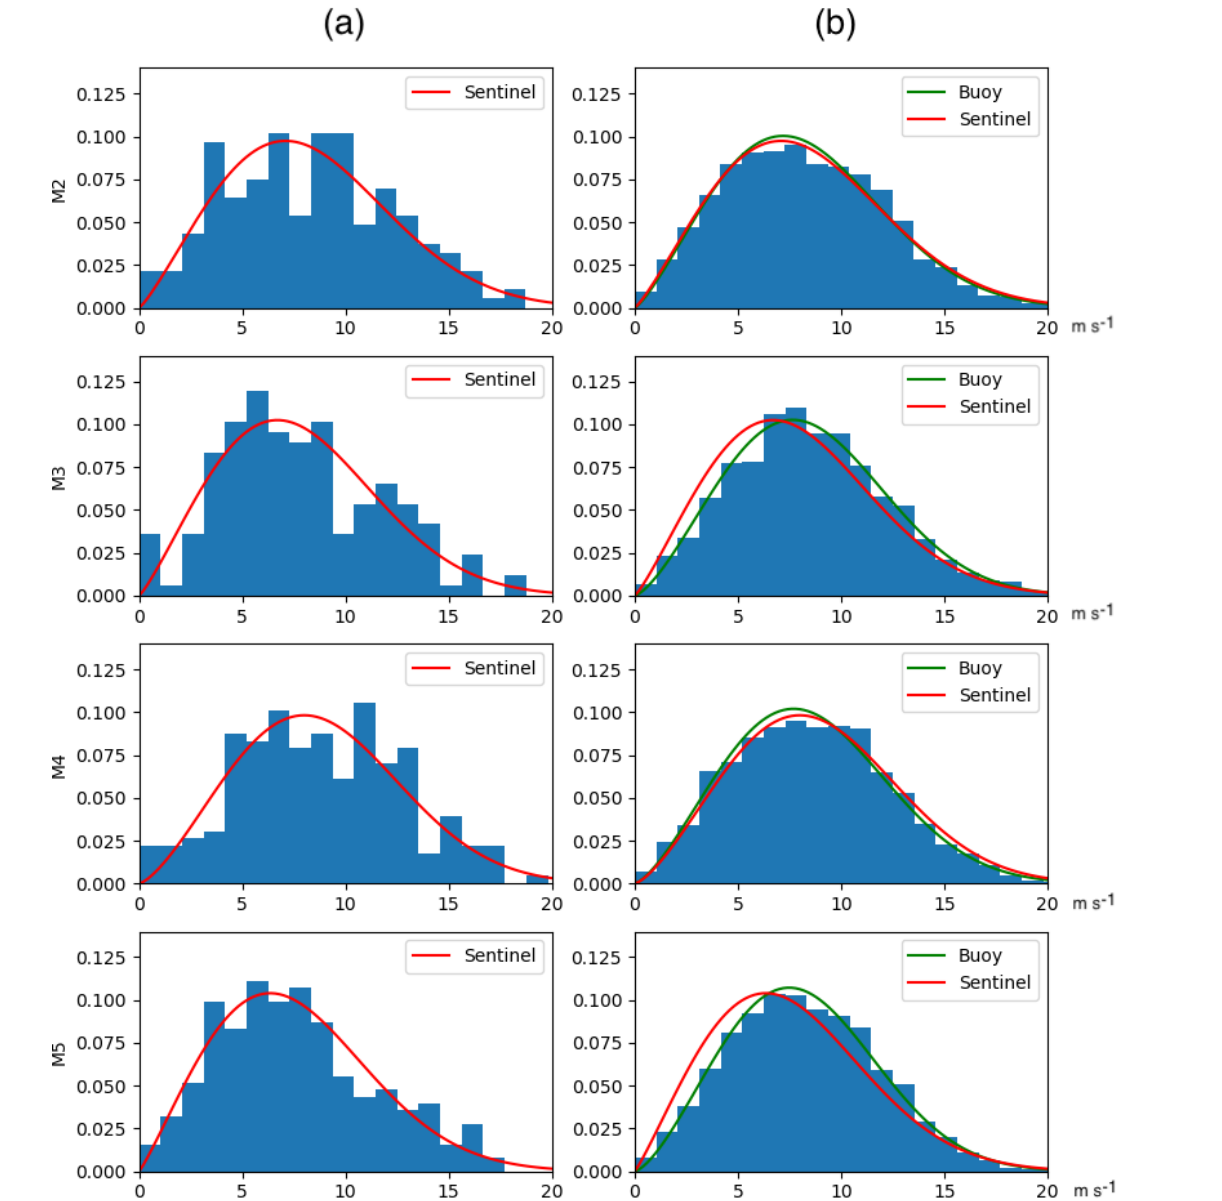
Figure 5. Wind speed histograms of Sentinel-1 SAR Level 2 OCN with Weibull fit (red curves) (a) . Wind speed histograms of in situ buoy data at the same locations with Weibull fits (green curves) (b) . The Weibull fits of satellite data (red curves) have been reproduced over the corresponding buoy data (b) to allow a visual comparison with their Weibull fits in